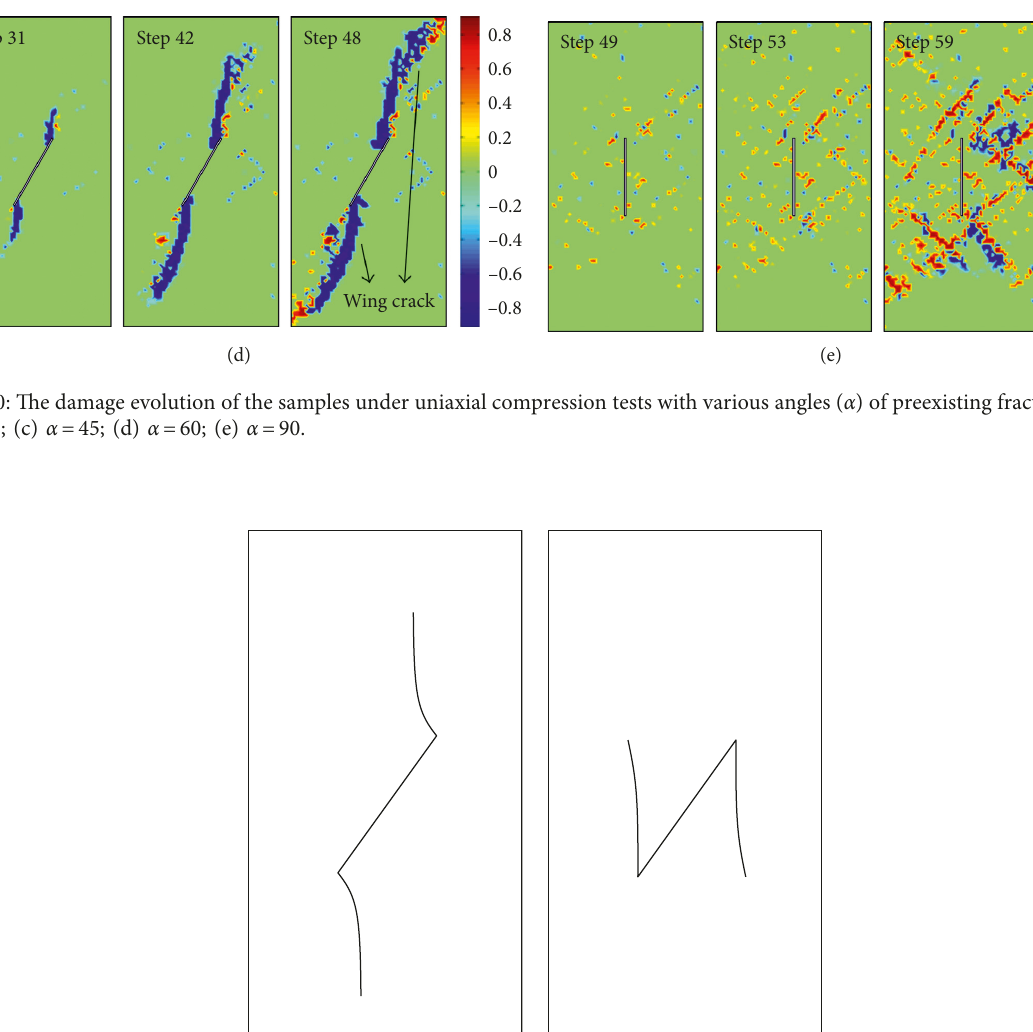
Figure 11: Crack patterns in the specimen with preexisting fracture: (a) wing cracks; (b) antiwing cracks.